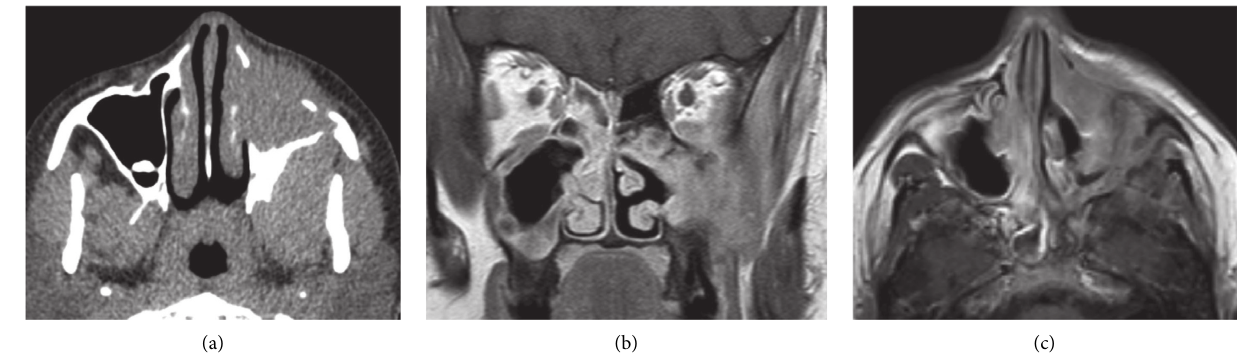
Figure 3: IgG4 disease. A 31-year-old female presented with epistaxis and medial-gaze diplopia. (a) Axial unenhanced CTshows soft tissue opacification of the left maxillary antrum with destruction of the antral walls and lateral pterygoid plate. (b) Coronal and (c) axial contrast- enhanced T1W demonstrates extension of the abnormally enhancing soft tissue (with restricted diffusion, not shown) into the orbit, pterygopalatine fossa, and involvement of the left infraorbital